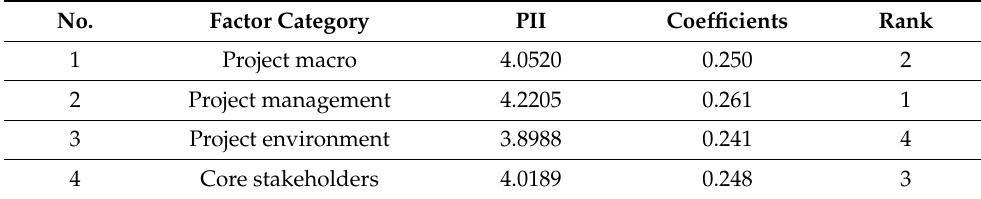
Table 6. Construction project cost overrun factor